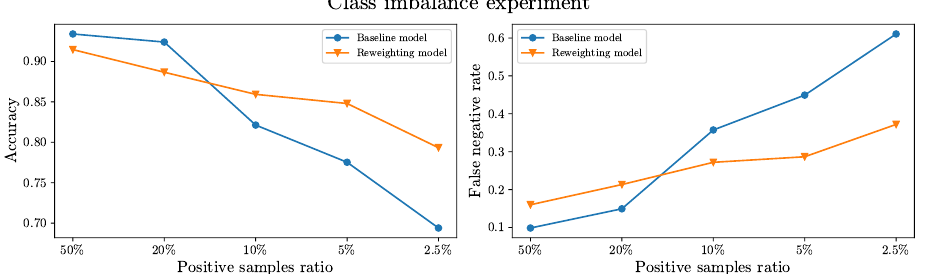
Figure 8. The class imbalance experiment with the ResNet18 model. Accuracy and false negative rate scores on the test dataset are visualised for the baseline and the reweighting model. The training sets had five different ratios of positive samples from 50% to 2.5%. The test set contained 75 positive (29 original + 46 generated) and 75 negative samples. The results are the mean average over 10